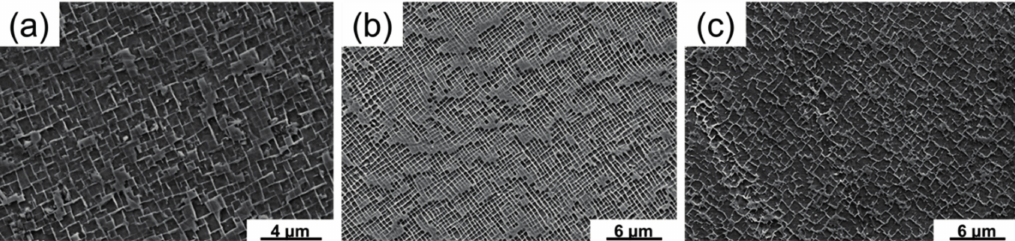
Figure 1. The microstructure morphologies of three nickel-based single crystal superalloys: ( a ) Alloy 1, ( b ) Alloy 2 and ( c ) Alloy